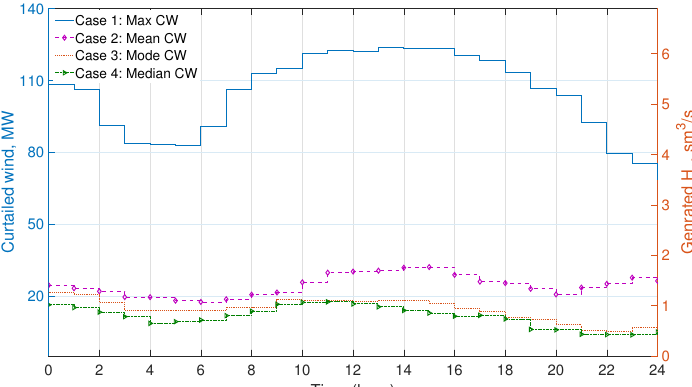
Figure 5. Mean, median, and maximum cases of curtailed wind extracted from annual Irish curtailed wind with generated hydrogen using (variable capacity) PEM electrolysers.